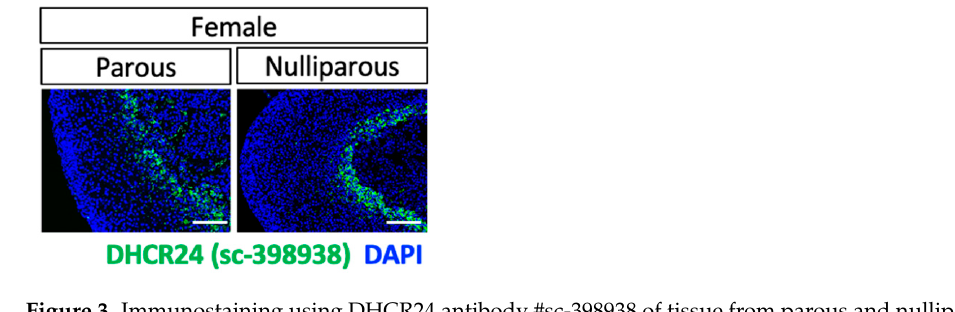
Figure 3. Immunostaining using DHCR24 antibody #sc-398938 of tissue from parous and nulliparous euthyroid wild-type B6 mice. The cell nuclei were counterstained with DAPI (blue). Scale bars, 130 µm.